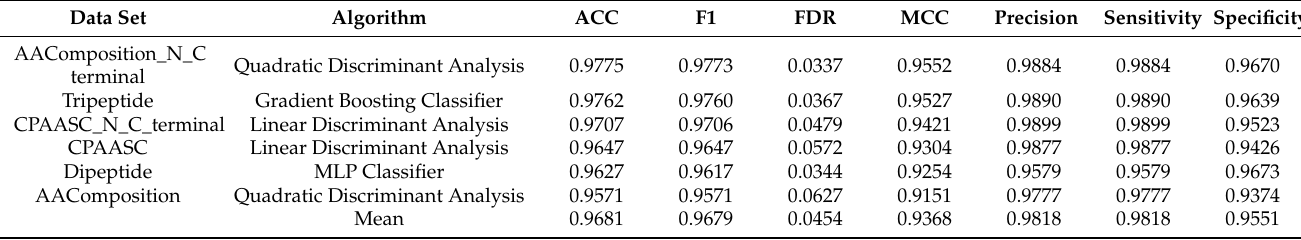
Table 4. Summarized results of the evaluation models built with the RLPs/RLKs datasets.